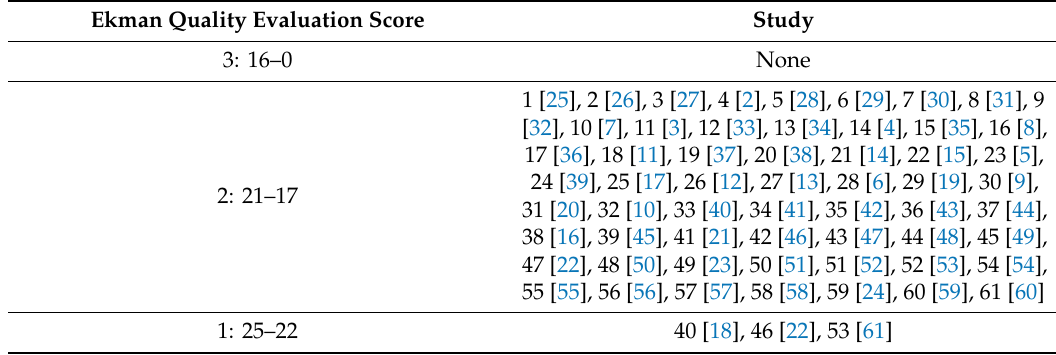
Table 2. Ekman quality evaluation scores of